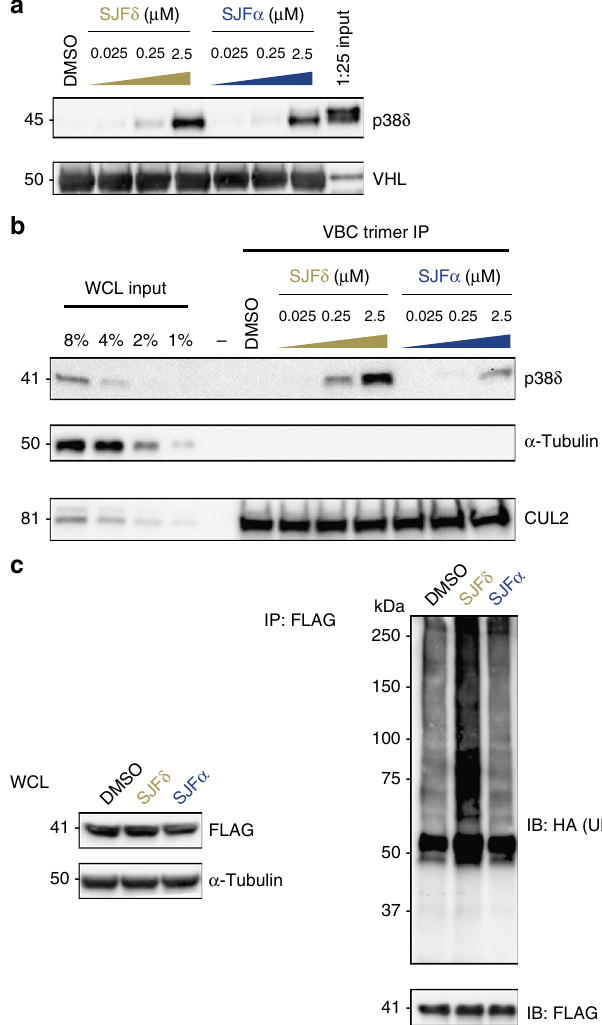
Fig. 4 Differential p38 δ :PROTAC:VHL complex af fi nities result in distinct cellular ubiquitination. a Both SJF α and SJF δ pull-down p38 δ in vitro, however, SJF δ maintains ternary complex at lower concentrations. As in Fig. 3a, GST-tagged VBC was used as a “ bait ” to trap recombinant p38 δ in the presence of vehicle (DMSO) or the indicated concentrations of SJF α or SJF δ . The rightmost lane represents a 1:25 dilution of initial input protein used in each pull-down. b SJF δ forms a more stable ternary complex with endogenous p38 δ and VHL than does SJF α . GST-VBC was immobilized on glutathione sepharose beads and incubated with MDA-MB-231 whole-cell lysate (WCL) in the presence of vehicle (DMSO) or the indicated concentrations of SJF α or SJF δ . Beads were washed and “ trapped ” proteins (i.e., those that engage in a ternary complex) were eluted with SDS sample